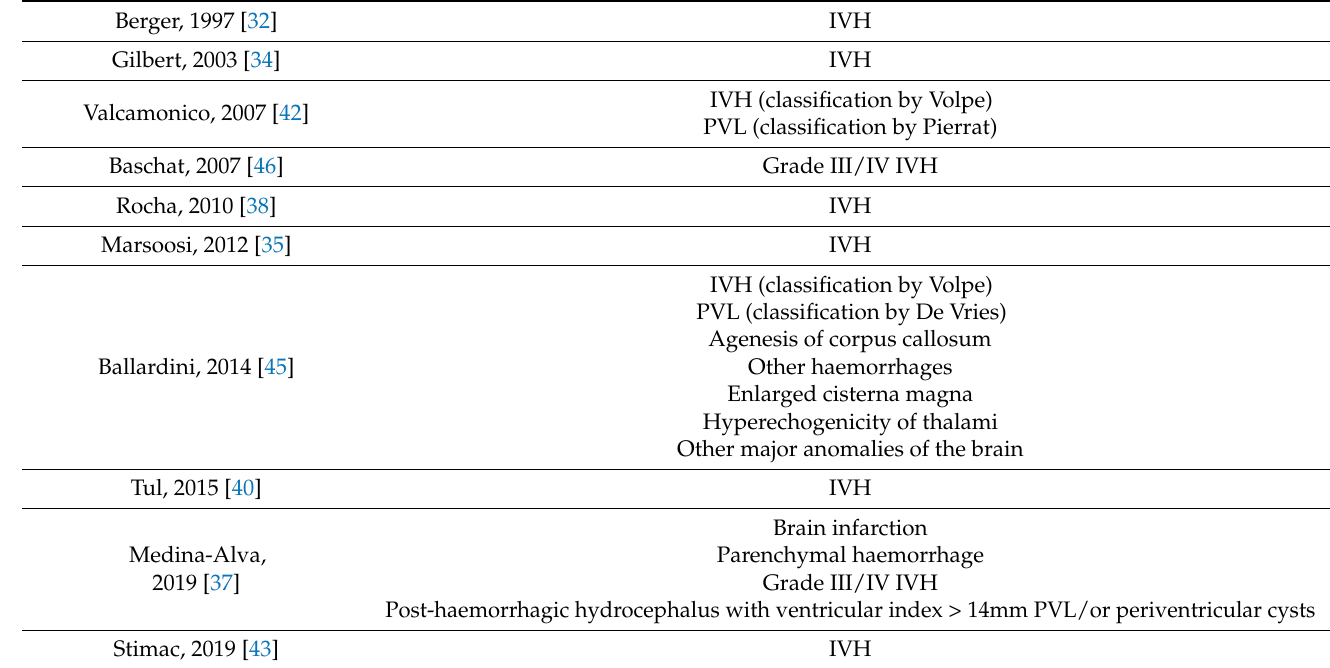
Table 5. Reported Abnormalities in MLPT FGR infants.